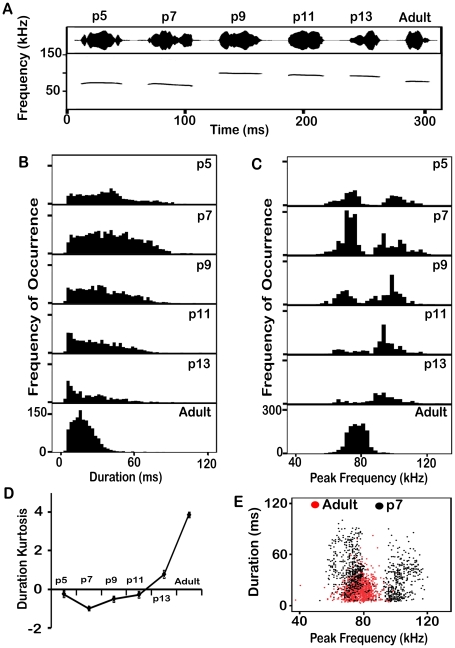
Analysis of the duration and frequency of flat syllables across ages.(A) The most typical flat syllable at each age. (B) Distributions of durations of the flat syllable at each age. Older pups are progressively less likely to produce longer flat syllables. (C) Distributions of the dominant frequency of the flat syllables at each age. At p5, p7 and p9 there are two clear peaks in the distribution, but by p11 there are fewer low frequency syllables. The frequency of the higher peak gradually reduces with age. (D) The kurtosis of the duration distribution gets more positive with age, indicating a more peaked distribution of duration. Bars represent the standard error of the mean. (E) Scatter plots of duration against frequency for flat syllables from animals aged p7 and adults. Although there is some overlap, the frequencies of adult syllables fall between those of the pup syllables.